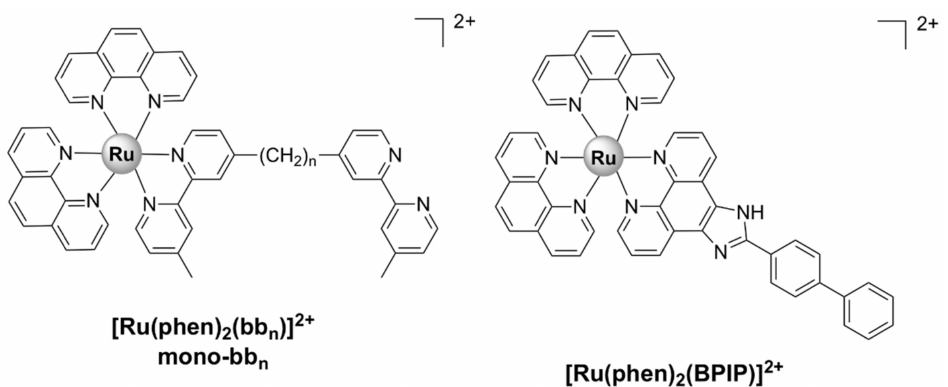
Figure 6. Chemical structures of heteroleptic Ru(II) complexes bearing 1,10-phenanthroline (phen)